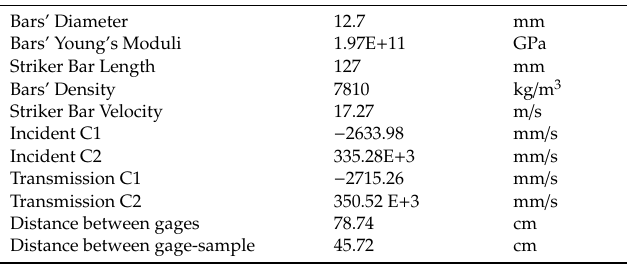
Table 3. Parameters of the split Hopkinson pressure bar test